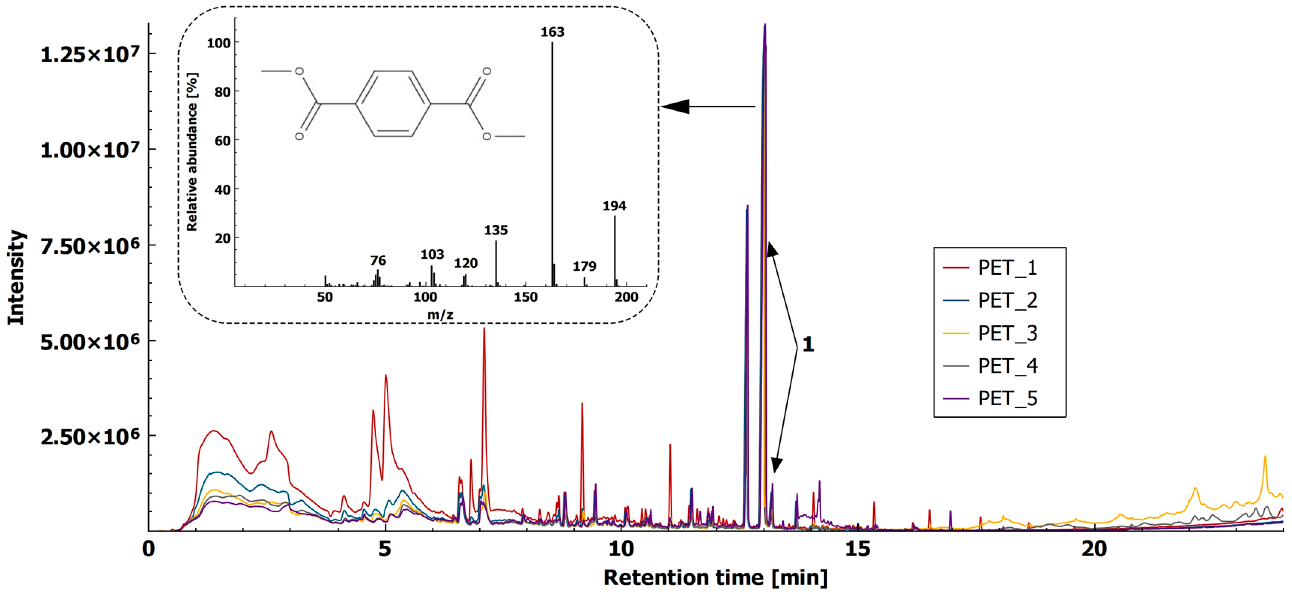
Figure 1. Headspace-solid phase microextraction gas chromatography–mass spectrometry (HS-SPME-GC–MS) extracted ion chromatogram (XIC, m / z 163) of PET (5 replicates) with mass spectra of dimethyl terephthalate.